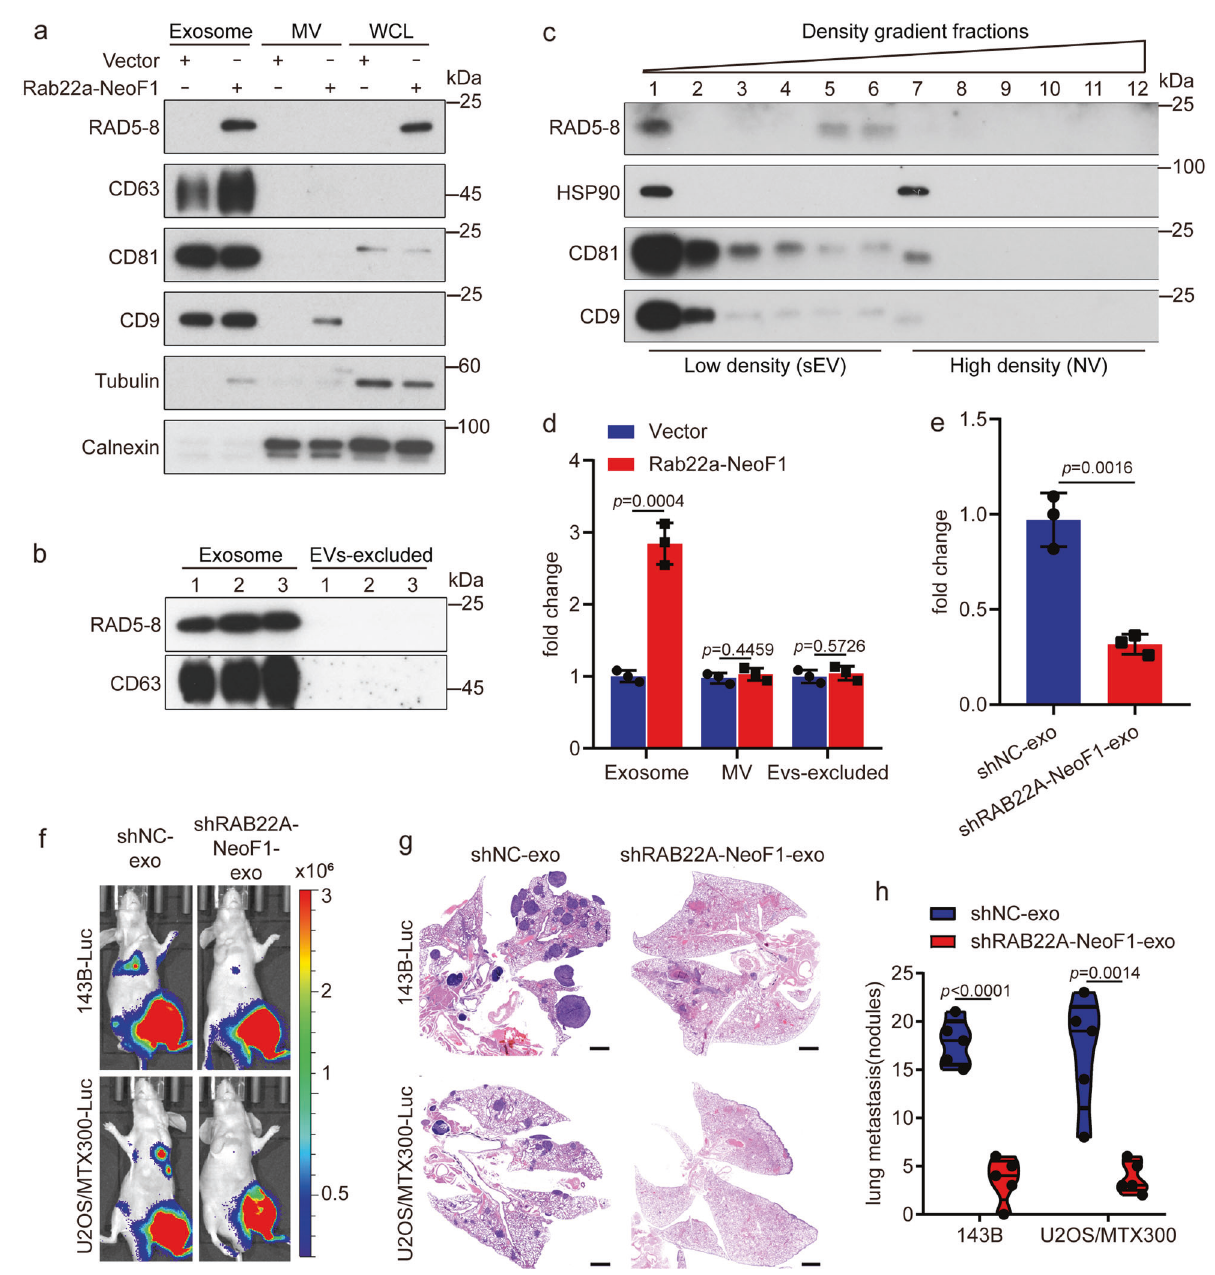
Fig. 2 Rab22a-NeoF1 fusion protein is secreted into exosomes to promote metastasis. a , b The exosomes (Exosome), microvesicles (MV), whole-cell lysates (WCL), and EVs excluded supernatant (EVs-excluded) derived from the indicated stable 143B cells were prepared and analyzed by Western blotting. c High-resolution (12 – 36%) iodixanol gradients centrifugation was performed using the exosomes derived from ZOS-M cells as described in “ Materials and methods ” and followed by Western blotting. Data in a – c are representative of n = 3 biologically independent experiments. d , e 143B cells were incubated with exosomes (Exosome), microvesicles (MV), and EVs excluded supernatant (EVs- excluded) derived from the indicated stable 143B cells ( d ) or exosomes derived from the indicated stable ZOS-M cells ( e ) for 24 h. Cells were collected and subjected to the invasion assay. Data are mean ± s.d. of n = 3 biologically independent experiments. P values are shown. f – h Representative IVIS imaging ( f ), H&E-stained lung sections ( g ), and quanti fi cation of lung metastatic foci ( h ) from mice orthotopically injected with the 143B-Luc or U2OS/MTX300-Luc cells under treatment of exosomes derived from the indicated stable ZOS-M cells. n = 5 biologically independent mice. Data are mean ± s.d. P values are shown. Scale bar, 2 mm well as the lung metastases of 143B-Luc cells in the orthotopic these KFERQ-like motifs in cells, and found that the 141-142AA osteosarcoma metastasis model in vivo (Fig. 3f – h and Supplemen- mutant of Rab22a-NeoF1 almost lost its binding to HSP90 and tary Fig. 3g). These results reinforce that Rab22a-NeoF1 fusion completely abrogated its secretion into exosomes (Fig. 3c, d). Most protein is sorted into exosomes by binding to HSP90 via one of its importantly, the exosomes from cells stably expressing the 141- KFERQ-like motifs (RVLFLN 142 ) to promote lung metastases of its 142AA mutant of Rab22a-NeoF1 lacked the enhancement of cell migration and invasion in both U2OS and 143B cells (Fig. 3e), as negative cancer cells. Signal Transduction and Targeted Therapy (2021)